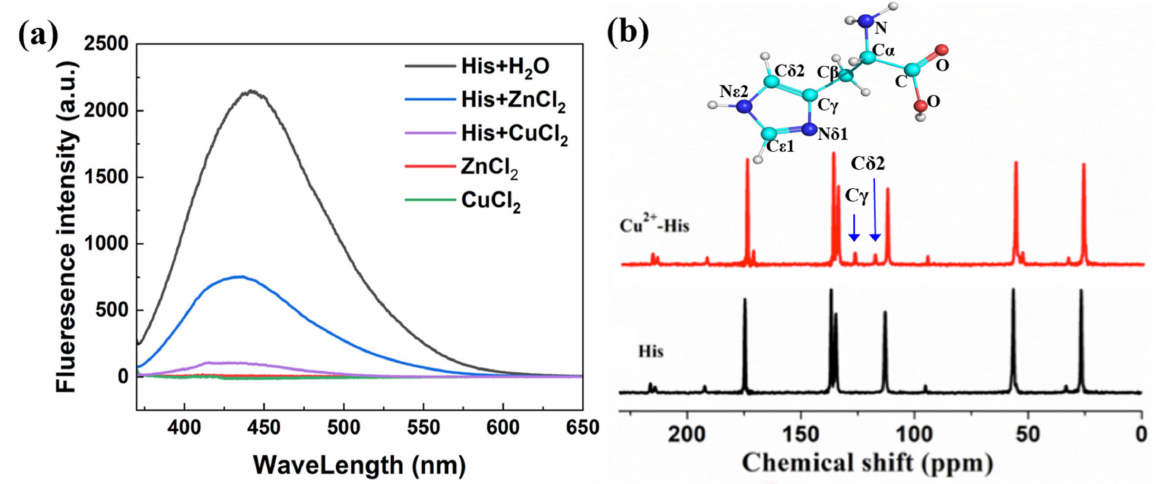
Figure 2. Fluorescence and NMR spectra on His in different solutions. ( a ) Fluorescence spectra of His in pure water, His in ZnCl 2 solution, His in CuCl 2 solutions (50 mM), ZnCl 2 solution and CuCl 2 solution. The concentrations of His in all the solutions are 30 mg · mL − 1 . The concentrations of ZnCl 2 and CuCl 2 are 50 mM in all the samples. ( b ) Cross–polarization/magic angle spinning (CP/MAS) NMR C12 spectra of Cu 2+ –His and the control group (His in pure water). The C δ 2 and C γ peaks are